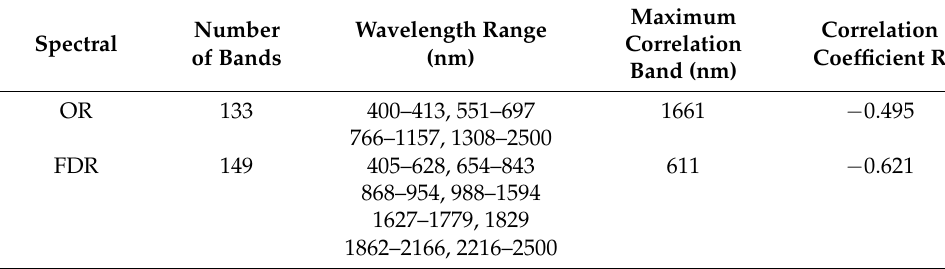
Table 4. Lasso feature selection band number and wavelength.